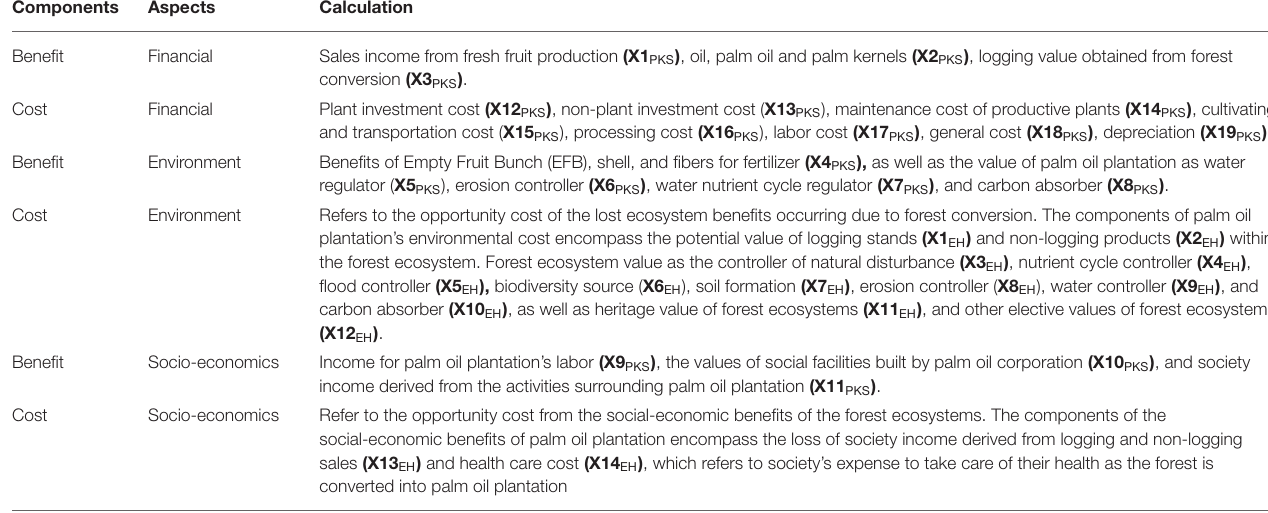
TABLE 2 | Cost-benefit components for palm oil